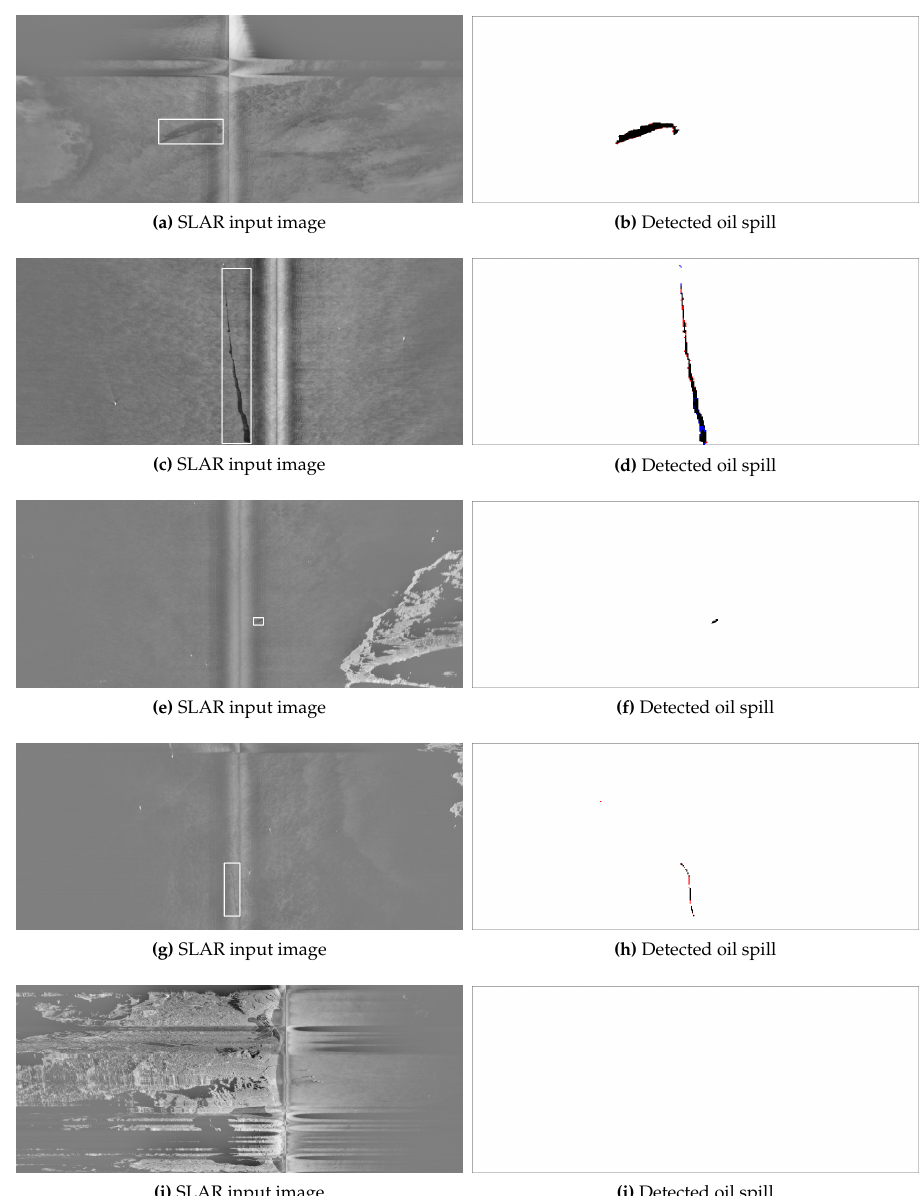
Figure 7. Results of processing five SLAR input images. The first column shows the original SLAR images (oil spills are marked with a bounding box), and the second column shows the detection results. White and black areas depict correct detections of sea and oil spills, respectively, and red and blue pixels (hard to see because they are few) depict FP and FN of oil spills, respectively.